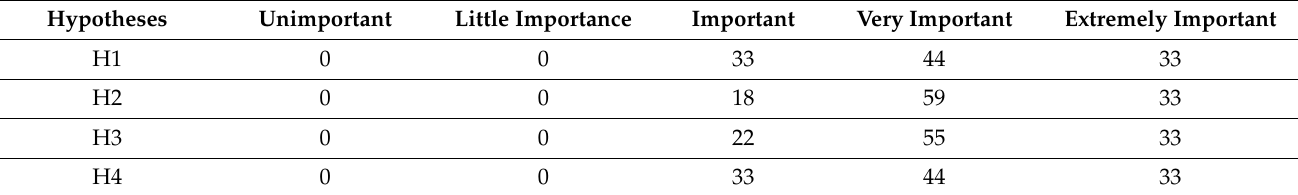
Table 2. The importance weight ofe each